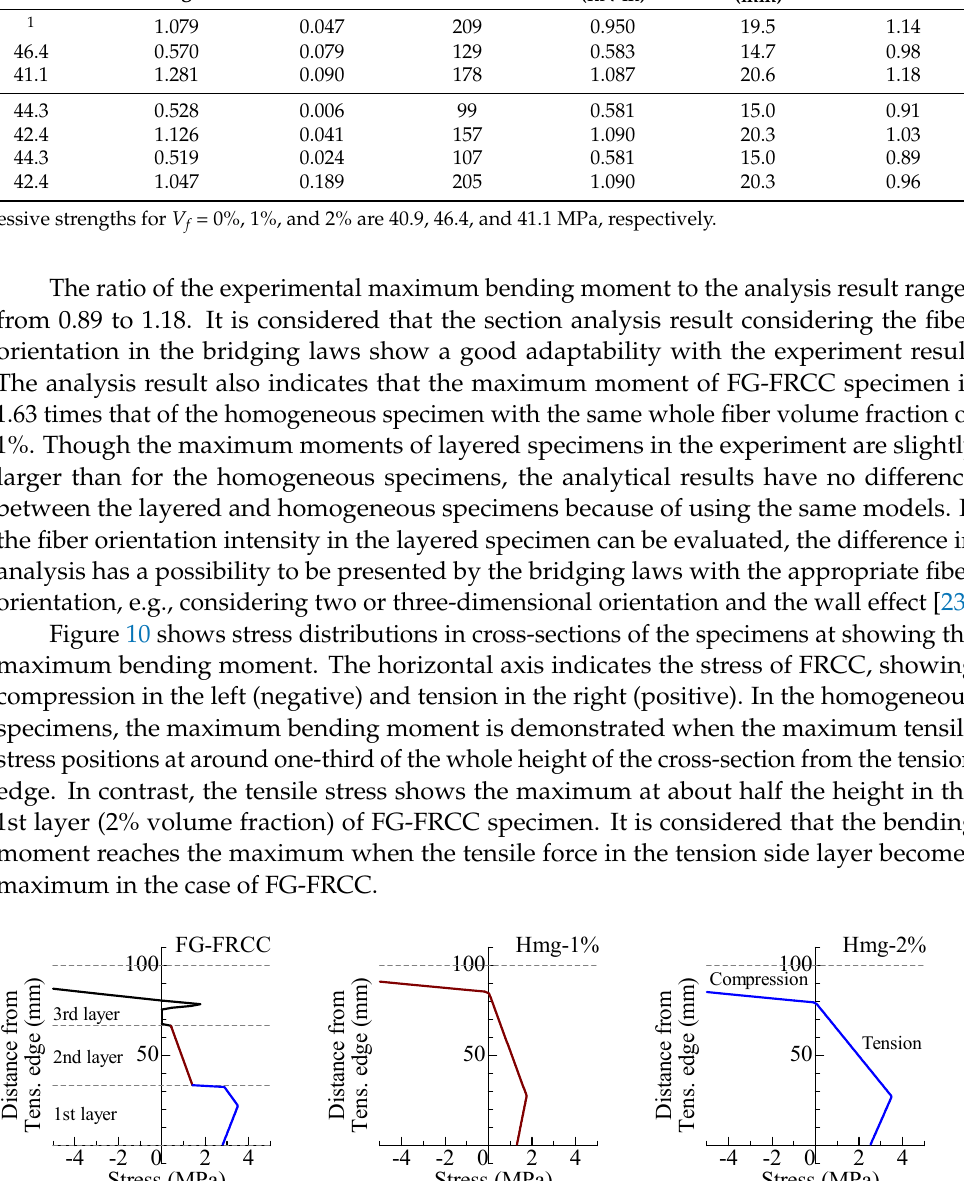
Table 4. List of maximum bending moment.